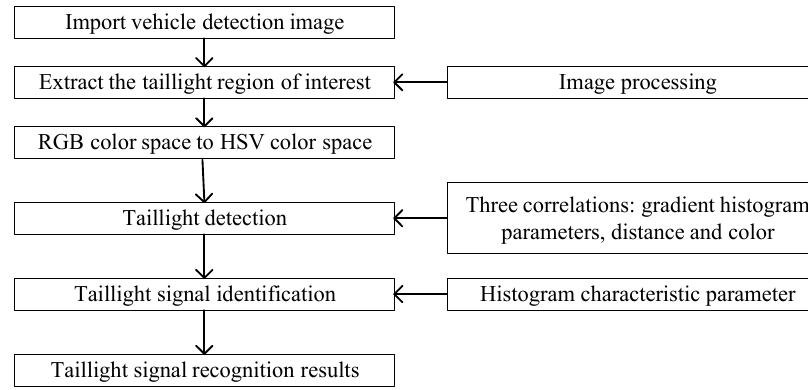
Figure 5. The process of taillight detection and light recognition.